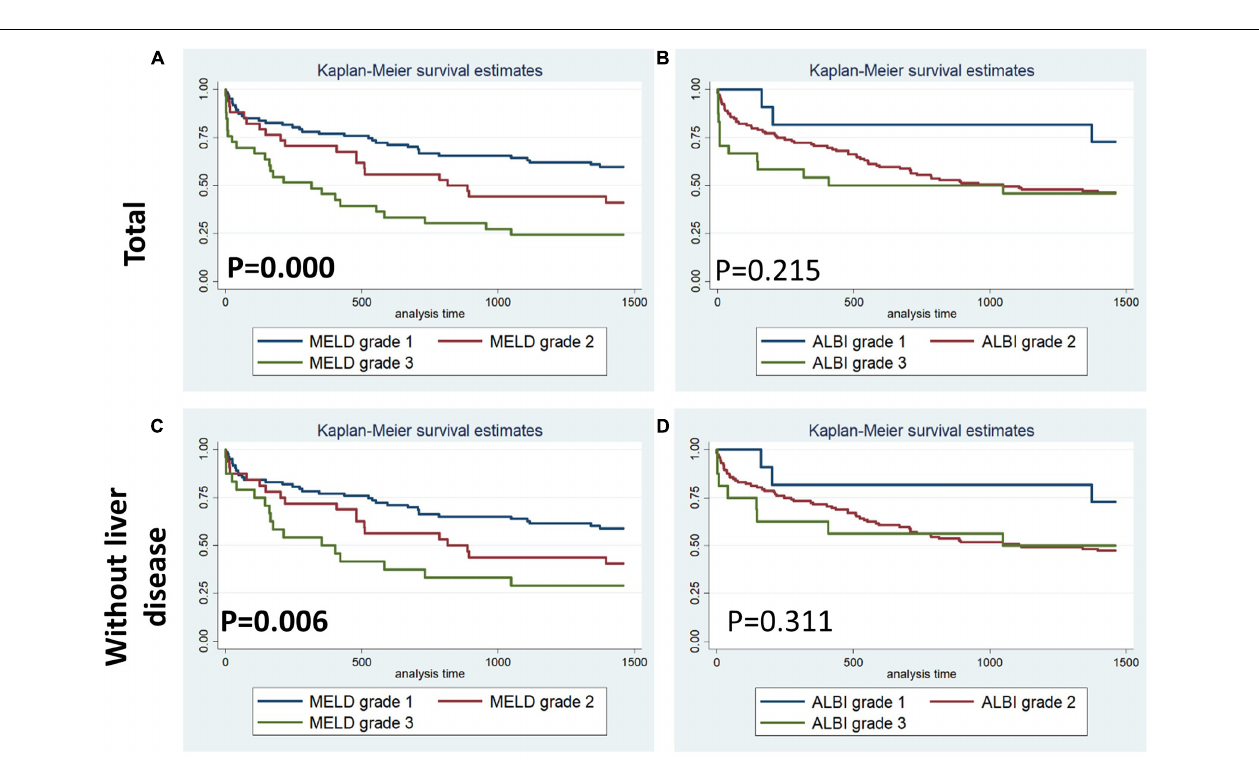
FIGURE 4 | Kaplan–Meier 4-year survival curves comparing patients by liver function score levels (MELD and ALBI score). (A,B) Total patients with PPH. (C,D) Patients with PPH and without liver disease.